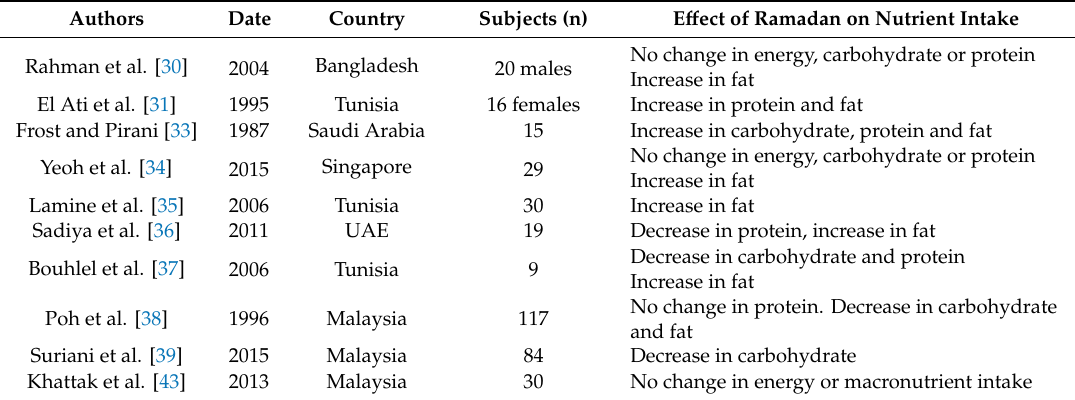
Table 2. E ff ect of Ramadan fasting on energy, carbohydrate, protein and fat